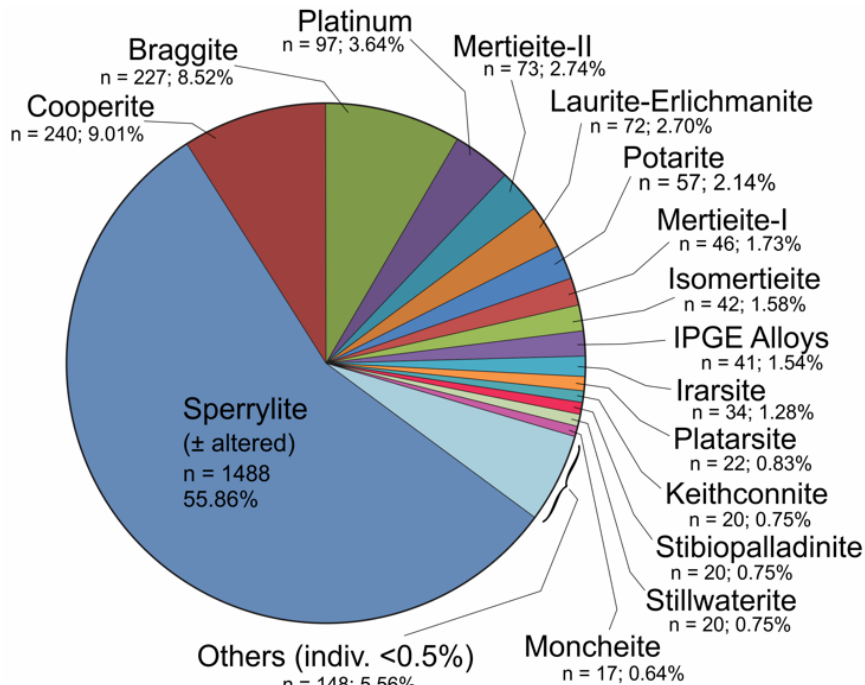
Figure 3. Major platinum-group mineral (PGM) species recovered from till in this study and their relative abundance. A total of 58 different PGM species have been identified. Table 1. List of rare PGMs identified by ARTGold TM in the studied till samples. These PGM species are grouped as “Others” in Figure 3.